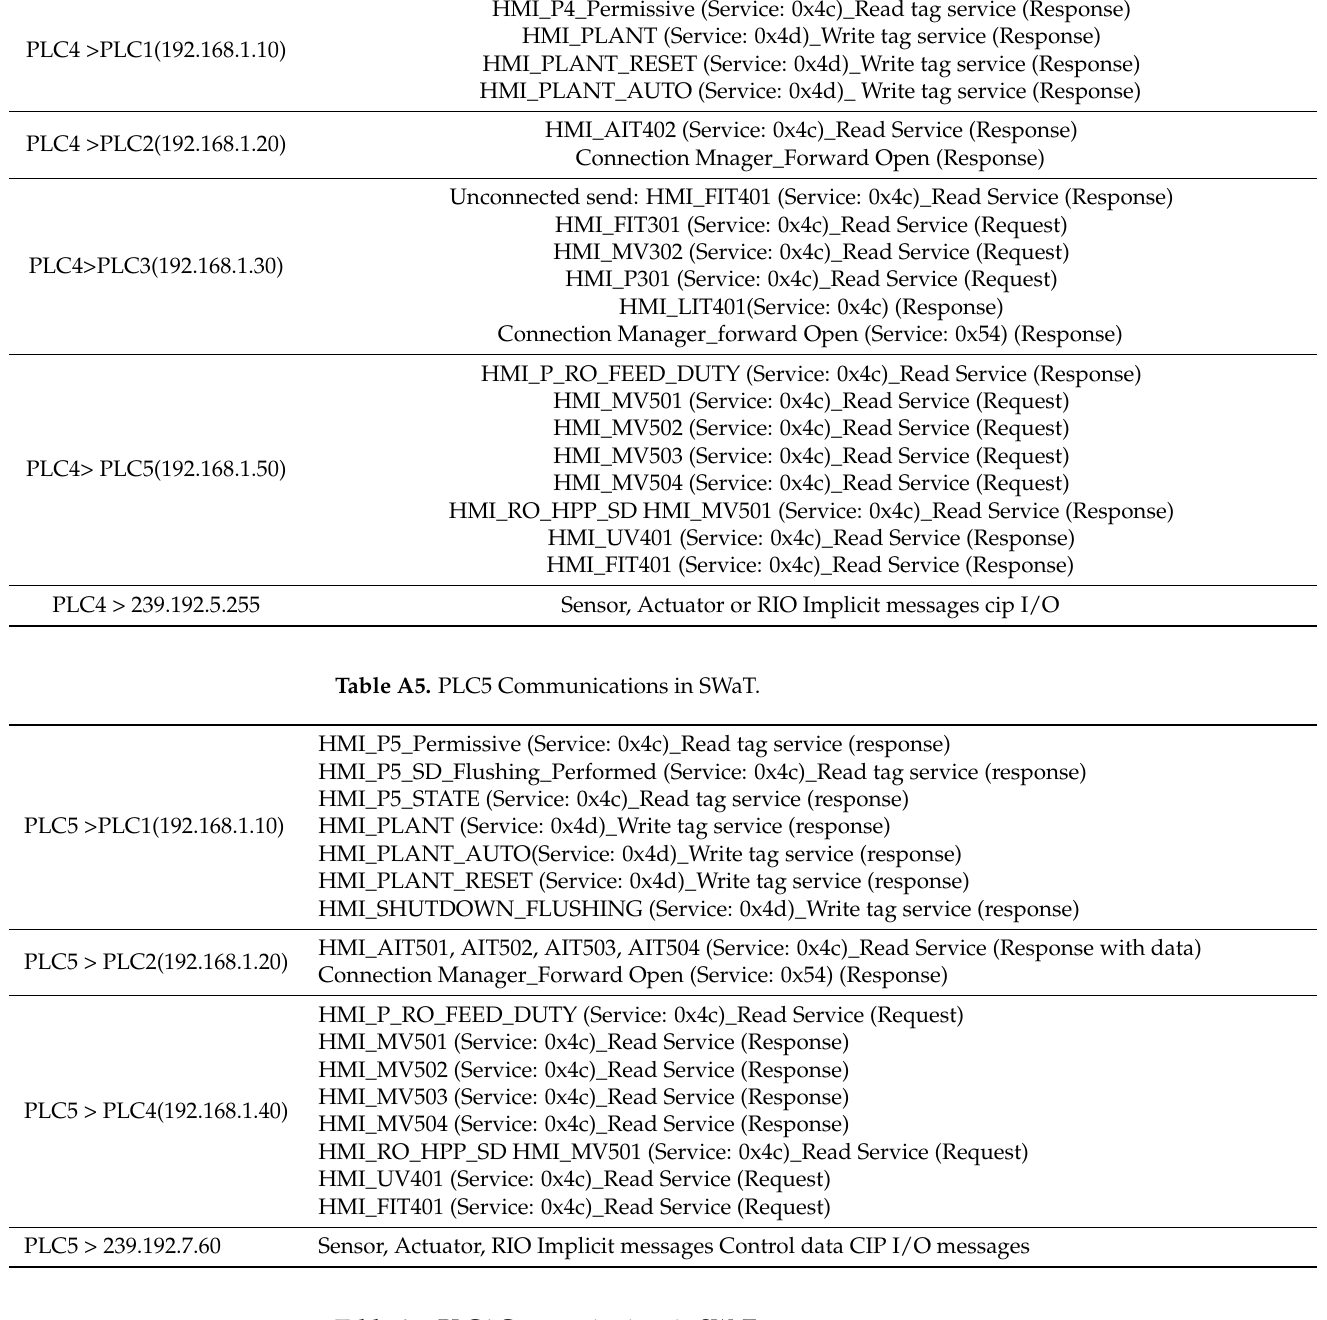
Table A6. PLC6 Communications in